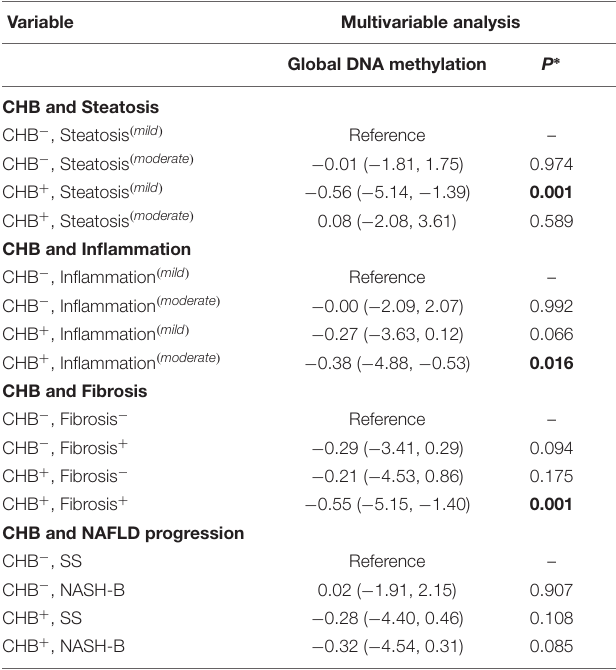
TABLE 4 | Multivariable analysis of global DNA methylation and histological variables in patients after adjusting for anthropometric and biochemical variables.